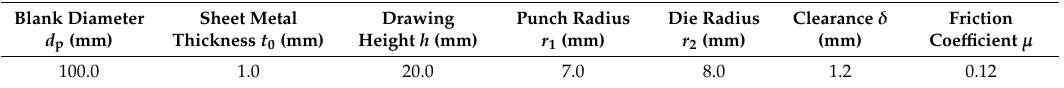
Figure 4. Stamping of tube-shaped part. Table 1. Parameters for drawing processes of tube-shaped parts. Table 1. Parameters for drawing processes of tube-shaped parts.